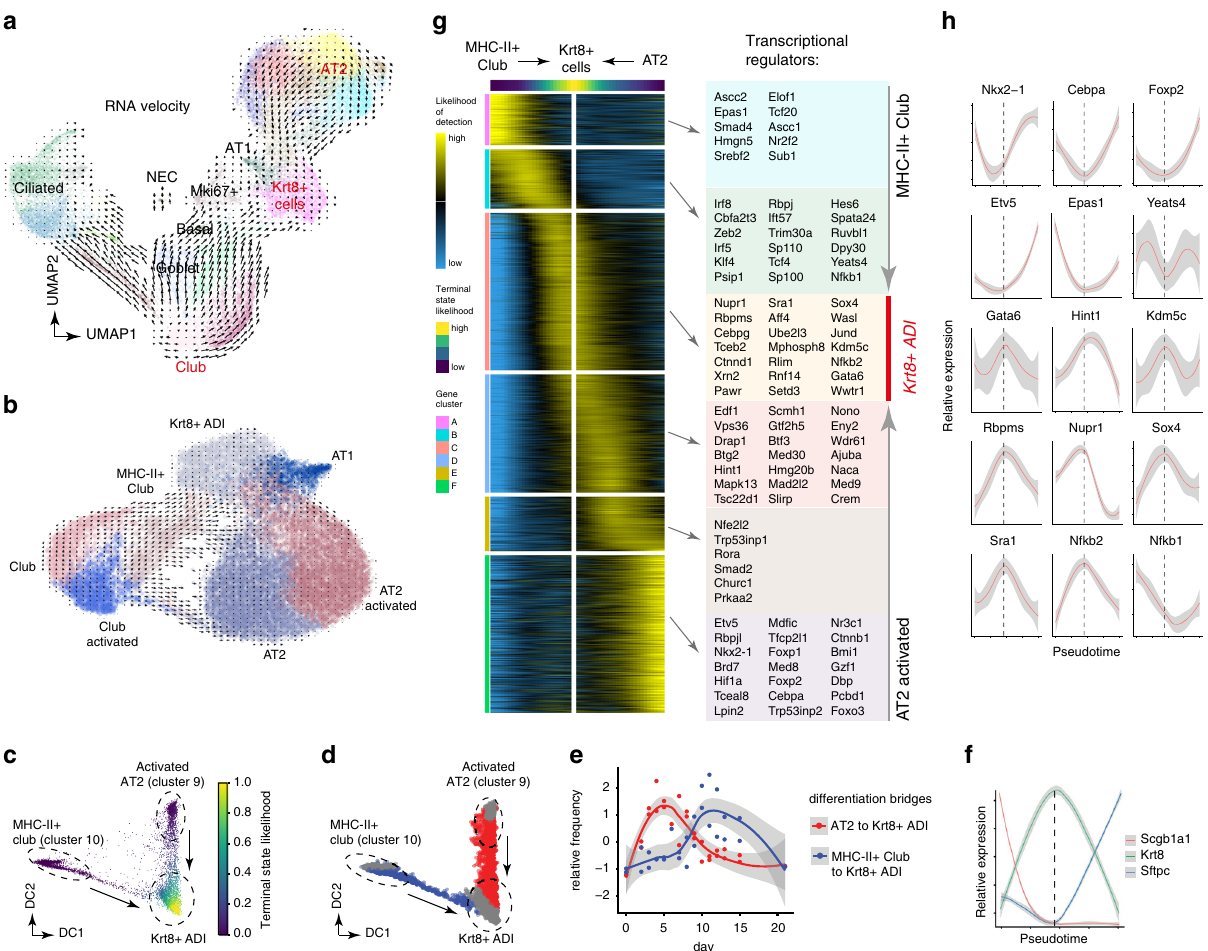
Fig. 6 Transcriptional convergence of MHC-II+;club and AT2 cells onto the alveolar Krt8+ADI cell state. a Velocity plot displays the UMAP embedding colored by Louvain clusters with velocity information overlaid (arrows). b Velocity plot of a subset of the data only showing alveolar identities and club cell subsets. RNA velocity shows contribution of Scgb1a1 + club cells to both Krt8 + ADI and AT2 identities. c Diffusion map of Louvain clusters 2, 10, and 9 colored by inferred terminal state likelihood reveals two distinct transdifferentiation trajectories from activated AT2 and MHC-II + club cells towards a Krt8 + cell state. d Diffusion map colored by groupings derived from Gaussian Mixed Model Clustering. Red and blue colors represent AT2 and MHC-II + club cell differentiation bridges towards the Krt8 + ADIs. Grey colors represent cells at endpoints. e The lines indicate smoothed relative frequencies across time points of cells within the AT2 (red) and MHC-II + club cell (blue) differentiation bridges. f The lines illustrate smoothed expression levels of Scgb1a1, Krt8, and Sftpc across the trajectory, marking cell identities. The dashed vertical line indicates the peak of Krt8 expression. g The heatmap shows the gene expression patterns along the differentiation trajectory based on the inferred likelihood of detection for 3036 altered genes. h Line plots show the smoothed relative expression levels of selected transcriptional regulators across the converging trajectories. The dashed vertical line indicates the peak of Krt8 expression. For ( e ), ( f ), and ( h ), gray colors represent the 95% con fi dence interval derived from the smoothing fi